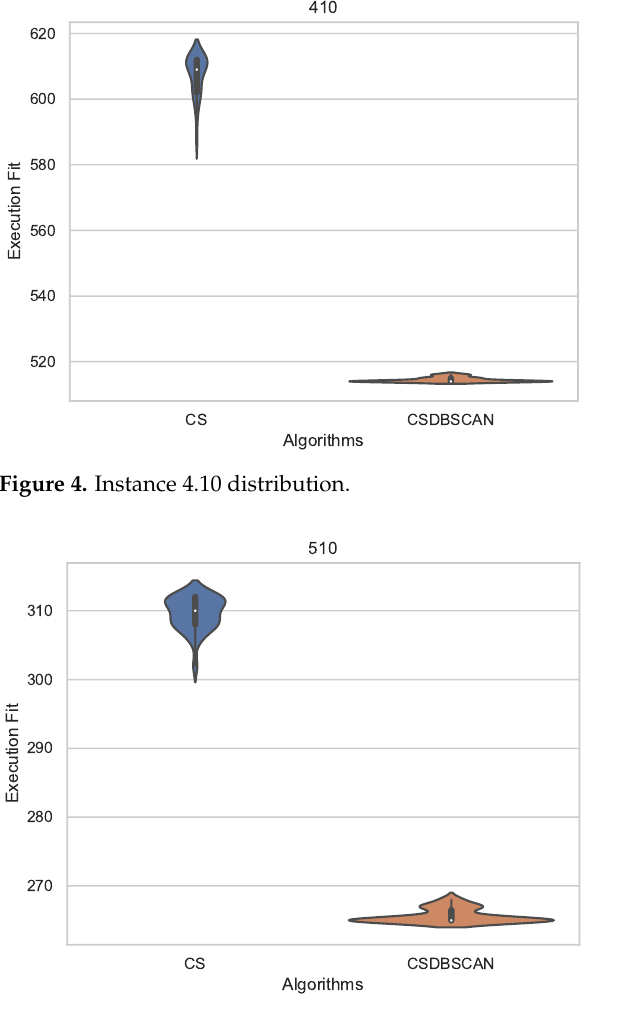
Figure 5. Instance 5.10